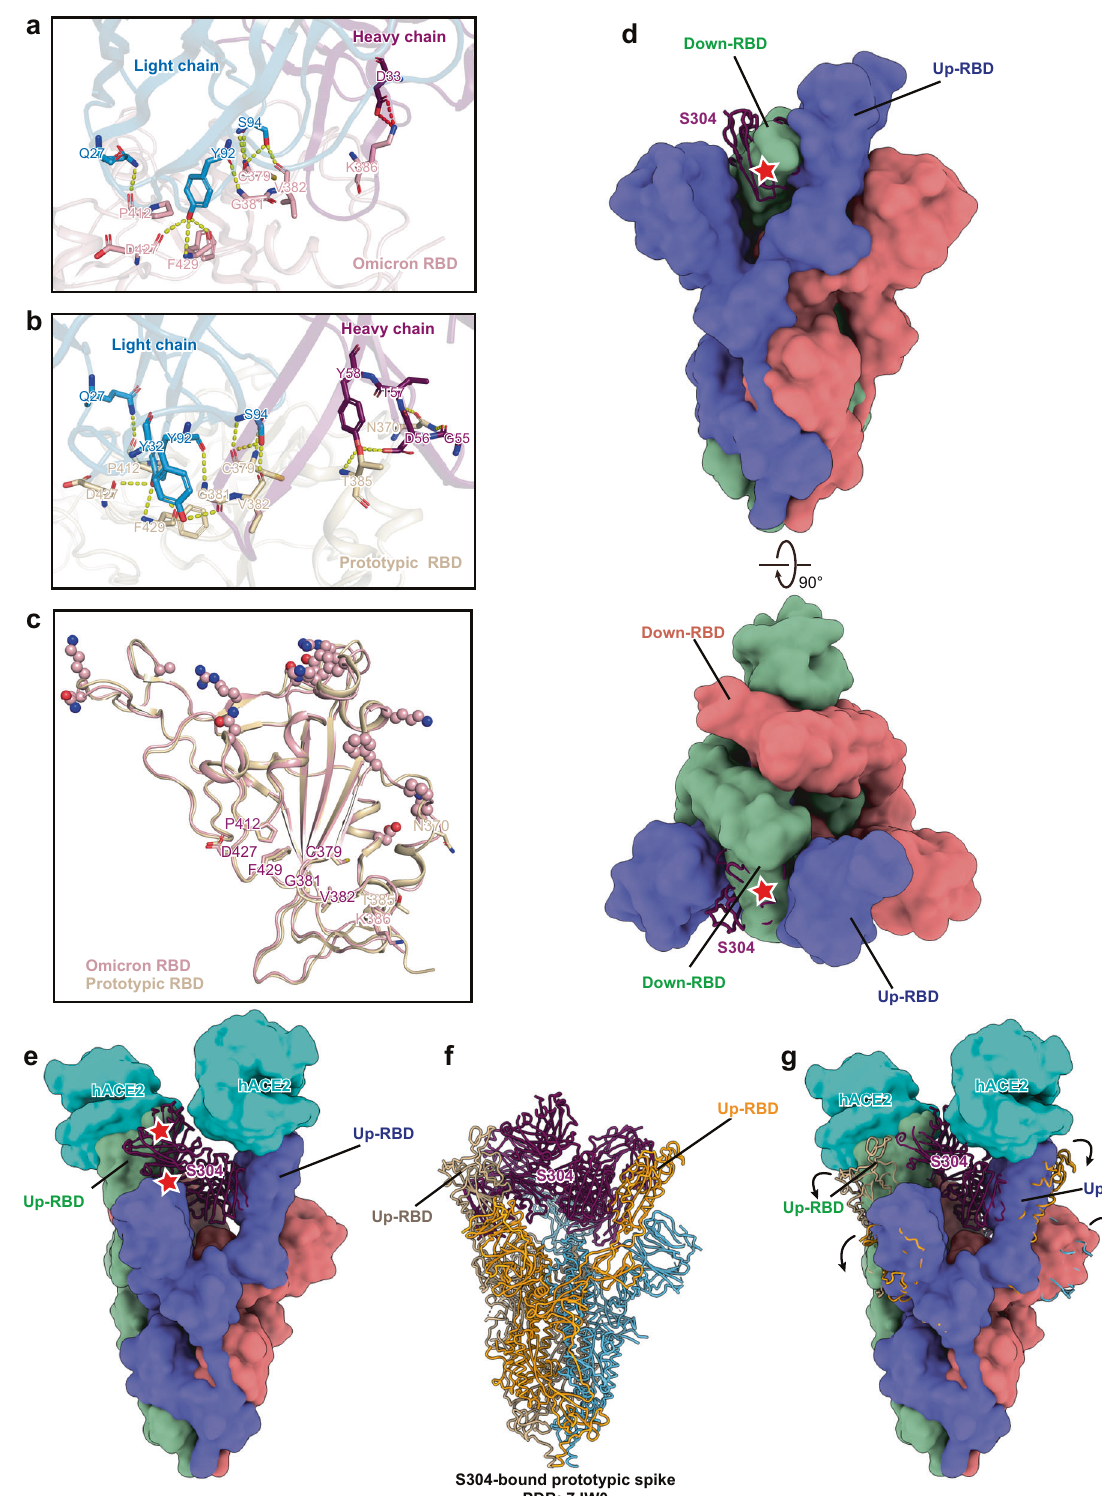
(Fig. 5d). The S304 Fab from the S304-bound prototypic spike (PDB: 7JW0) 24 was aligned with our Omicron RBD-S304 structure and these two structures were further superimposed into the Omicron spike with the two-RBD-up conformation from the Omicron spike- hACE2 complex, which revealed thatthe steric clashbetween the S304 and the up-RBD and NTD still exists (Fig. 5e). The structure of the prototypic spike bound to S304 (PDB: 7JW0) 24 and alignment with the